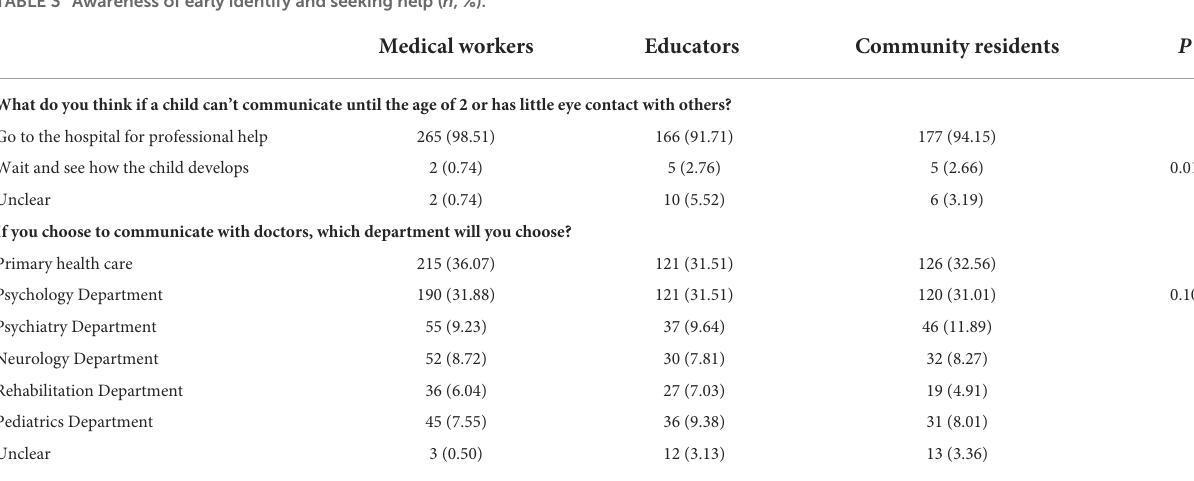
TABLE 3 Awareness of early identify and seeking help ( n , %).